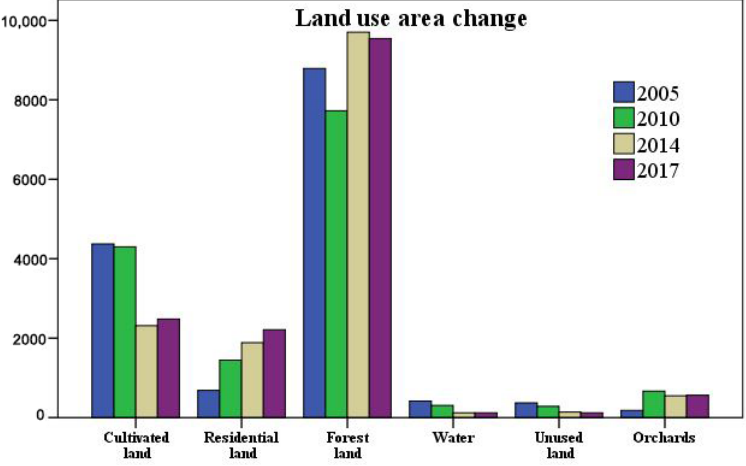
Figure 5. Change in land use area from 2005 to 2017.